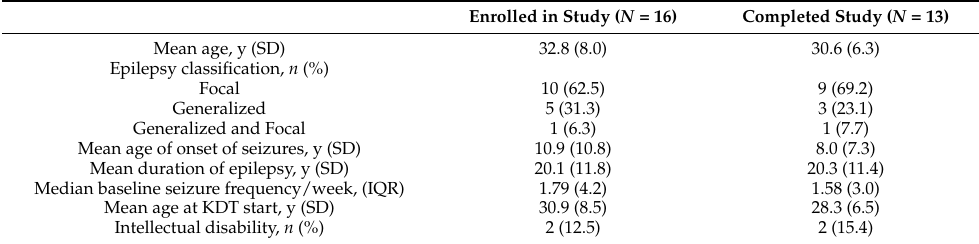
Table 1. Participant demographics and epilepsy